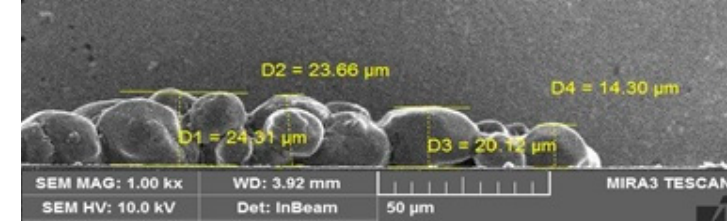
Figure 10. Cross-sectional image of conductive film for thickness measurement.